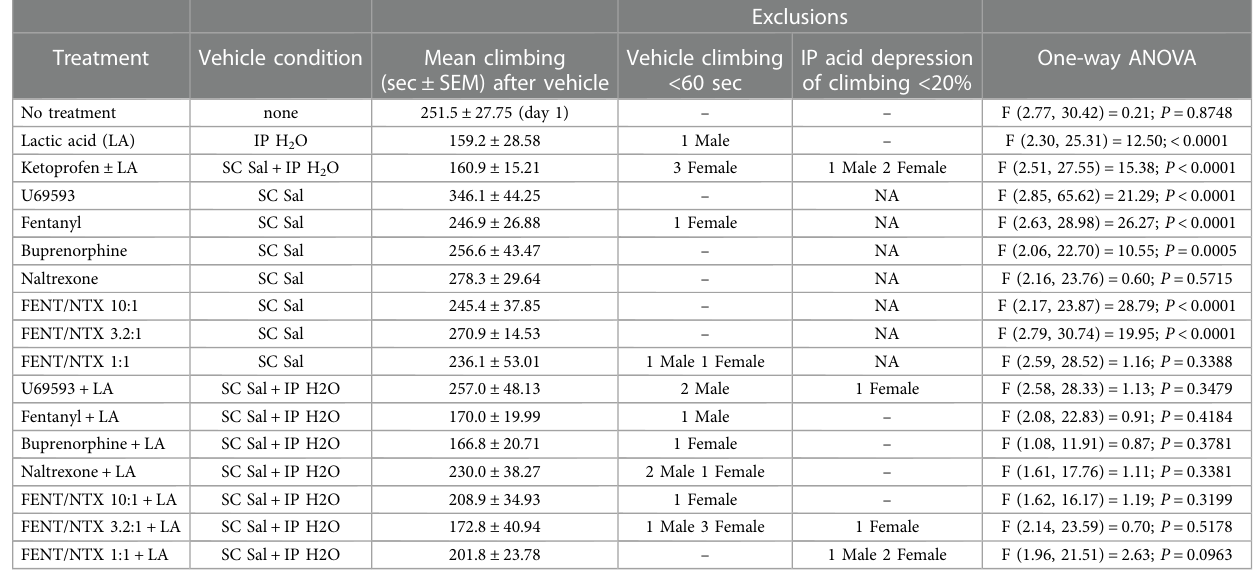
TABLE 1 Summary of vehicle control data and one-way ANOVA results for each group tested in the present study. The sex of excluded mice is indicated by M (males) or F (females). NA, not applicable.